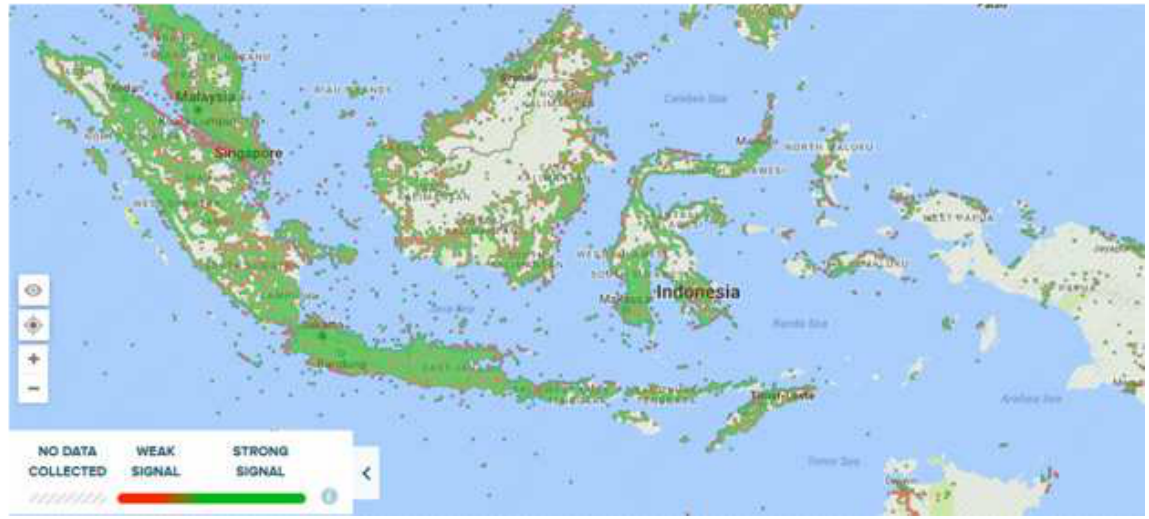
Figure 1. Digital infrastructure map of